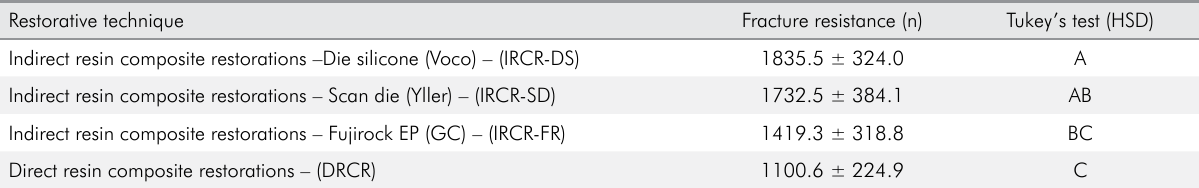
Table 3. Mean fracture resistance (N) values (SD) and results of Tukey’s HSD test. Restorative technique